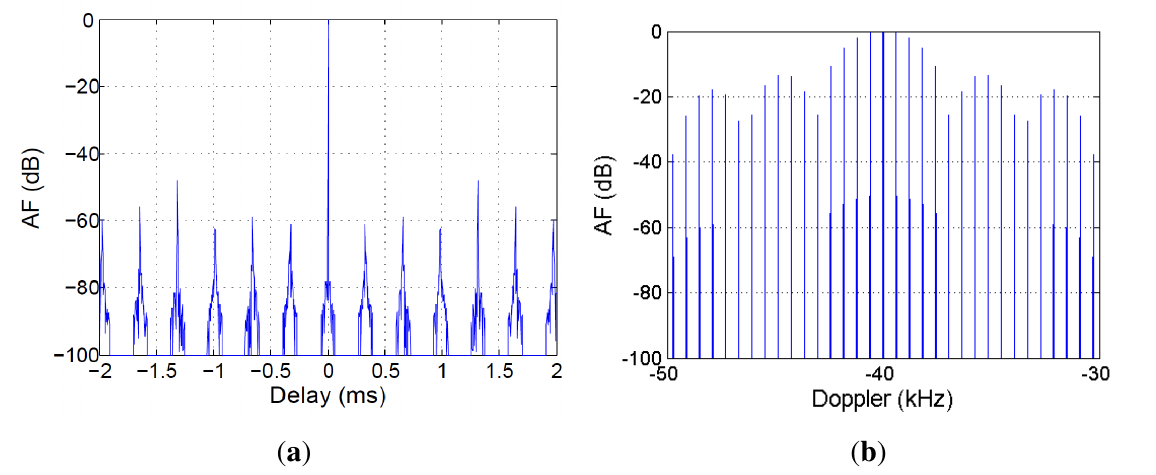
Figure 16. AF main cuts: ( a ) zero Doppler; ( b ) zero